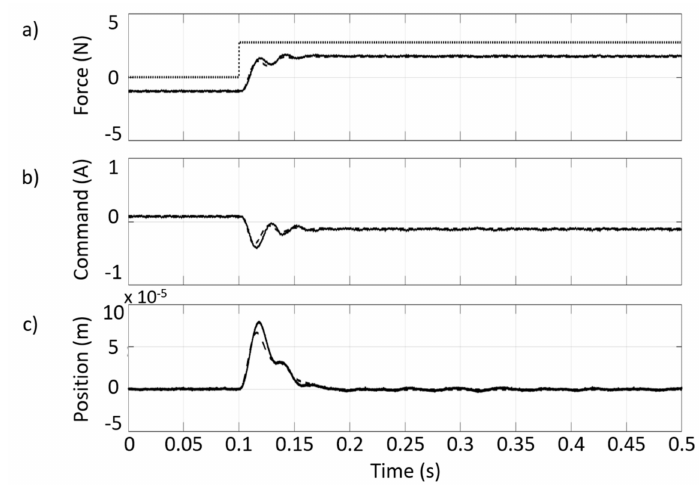
Figure 3. Step excitation through the actuators with a current i d = 0.25 A. ( a ) Nominal force applied to the system (dotted line); force from model simulation (dashed line); force estimated experimentally by the Kalman filter (solid line). ( b ) MPC command (dashed line: simulation result; solid line: experimental result). ( c ) Displacement of the mass (solid line: eddy current sensor direct measurement; dashed line: Kalman filter estimation).